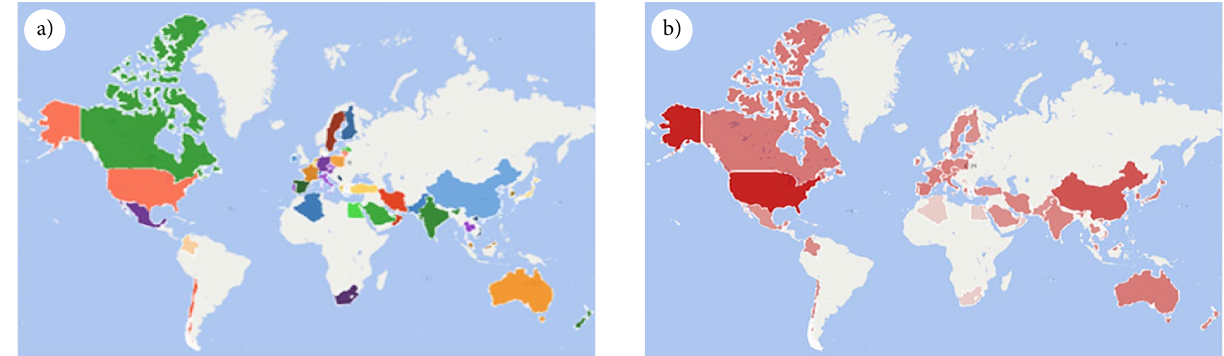
Figure 5. The distribution (a) and the density (b) of countries/regions published documents in the CACAIE